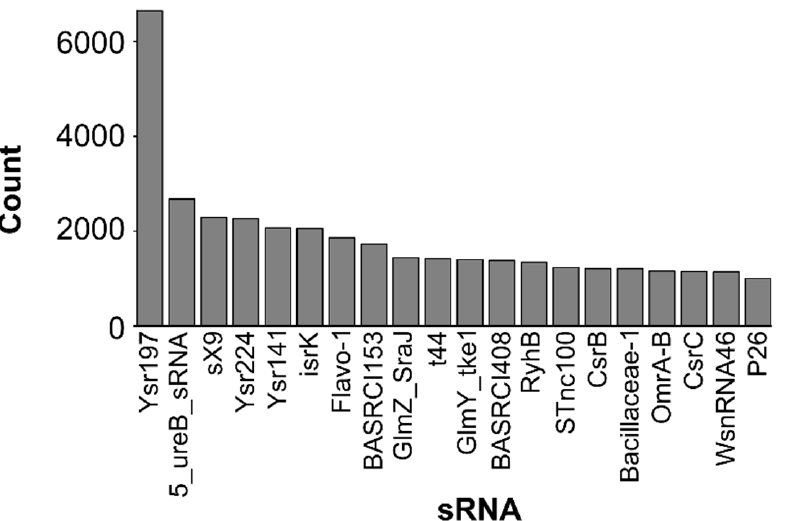
Figure 3. Top 20 sRNAs annotated in bacteria. Each individual occurrence of sRNAs were counted, even if some were found multiple times within the same genome. Only sRNAs with an E-value lower than 0.0005 were taken into consideration.